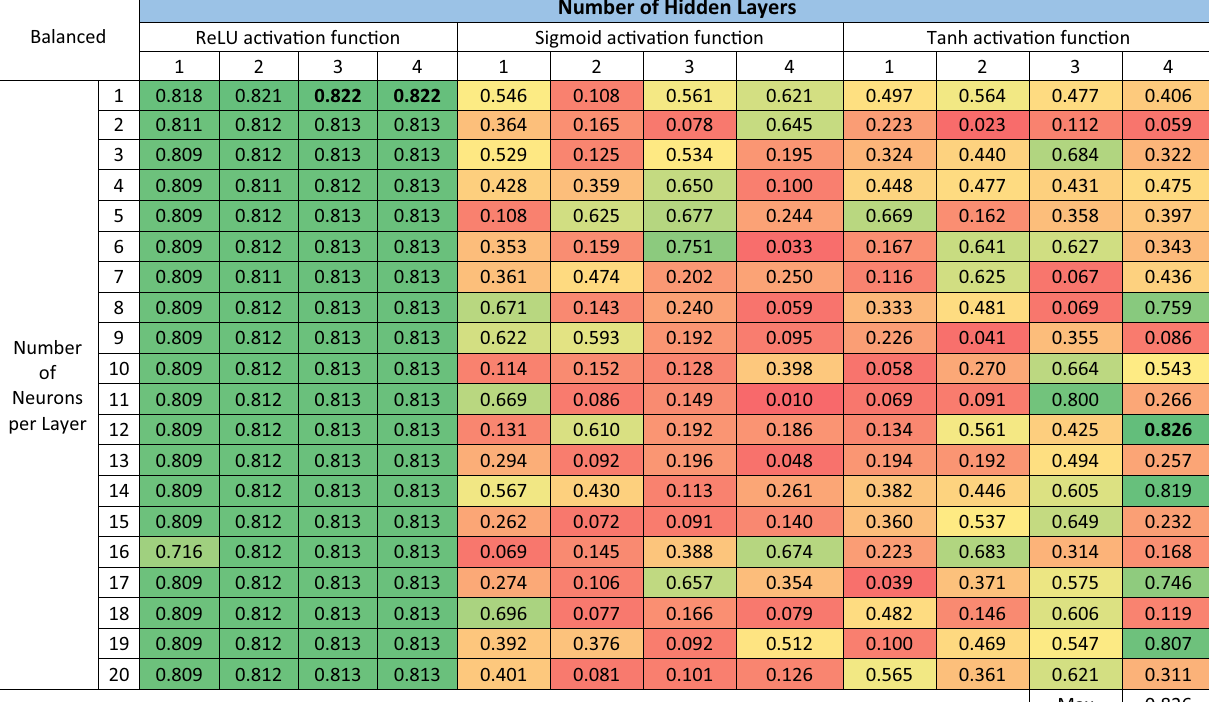
Number of Hidden Layers